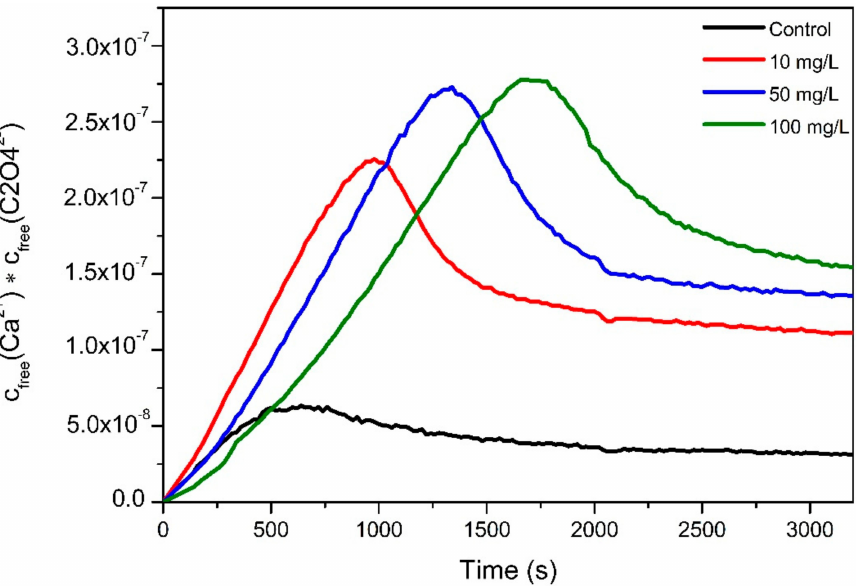
Figure 2. Time development of the ion activity product in titration experiments of CaOx in the absence and presence of three concentrations of PAA as an additive at pH